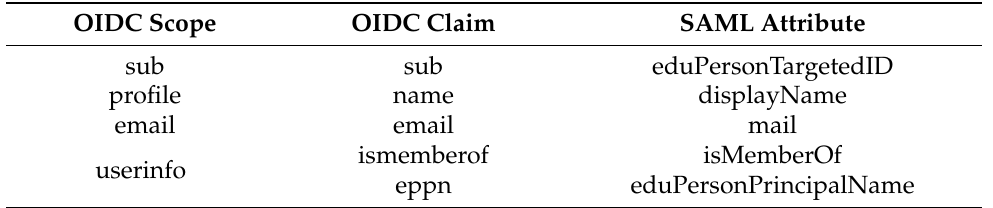
Table 1. Examples of mapping SAML attributes to OIDC